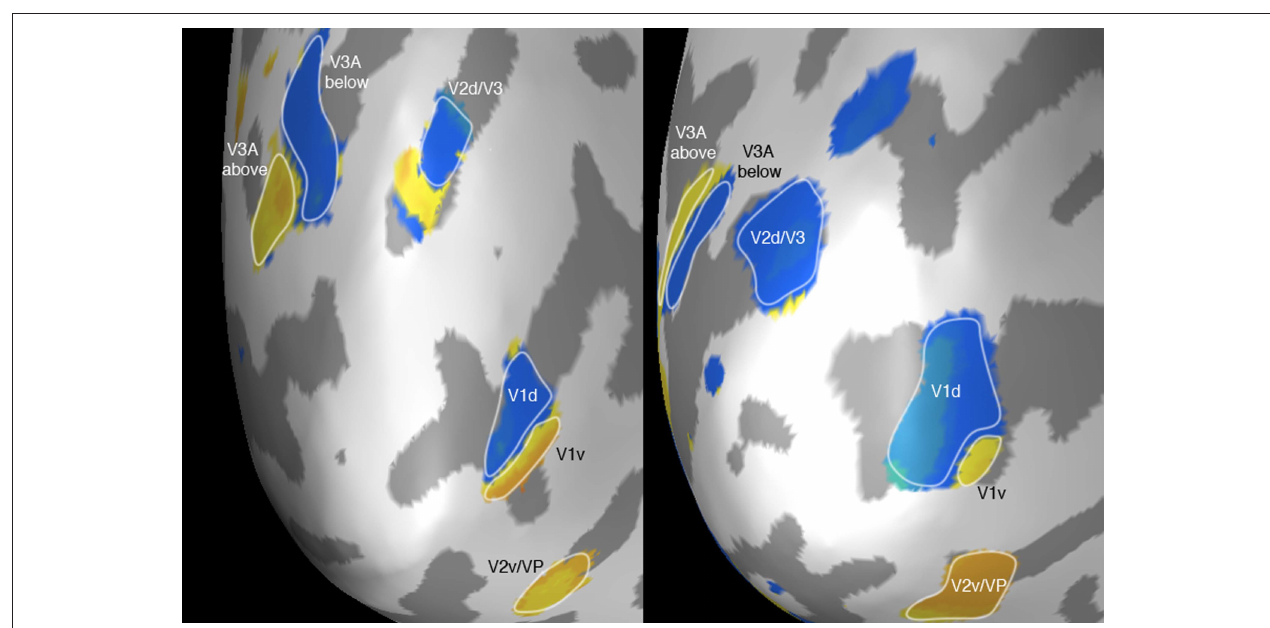
FIguRe 3 | The ROIs in the left hemisphere of two participants. The view is on the occipital pole of “inflated” cortices. Blue-turquoise areas show positive, yellow-orange negative RC values (positive RC values are retinotopic positions below the horizontal meridian). The circled areas show the selected ROIs in V1 (in the Calcarine sulcus), along the V2/V3 border in dorsal and ventral cortex, and in